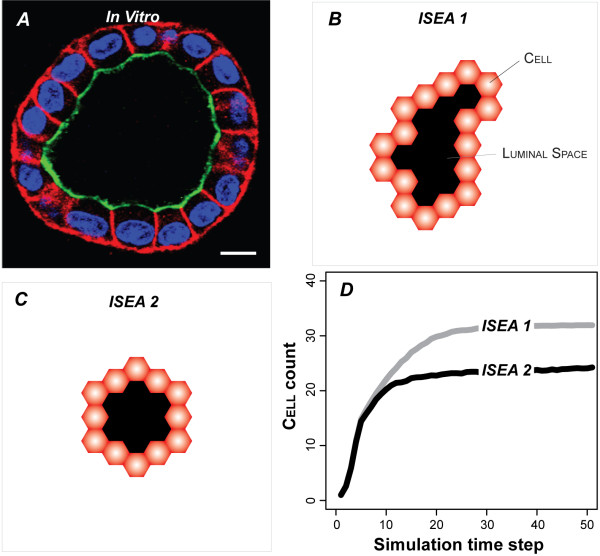
Cyst growth in simulated and in vitro MDCK cell culture. (A) MDCK cells grown in 3D matrix form lumen-enclosing cystic organoids surrounded by a layer of polarized cells. Cells composing the cysts maintain three surface types: apical (green), basal and lateral (red). Note the roundish contour typical of MDCK cysts. For growth and staining details, see [11]. Bar: 10 μm. (B) ISEA1 CELLS in EMBEDDED condition produced stable, cystic structures enclosing LUMINAL SPACE; all CELLS were POLARIZED (red). Many CYSTS like the one shown, had irregular, non-convex shapes unlike their in vitro counterpart. (C) ISEA2 CELLS under the same condition also developed stable CYSTS; almost all stabilized CYSTS had convex shapes. Note that a hexagonal CYST within the hexagonally discretized space maps to a roundish cross-section through a MDCK cyst in vitro. (D) ISEA2 CELLS formed CYSTS that tended to be smaller than those of ISEA1 (average 27 vs 31 CELLS per CYST). The CELL count represents mean values after 50 simulation cycles of 100 Monte Carlo runs.